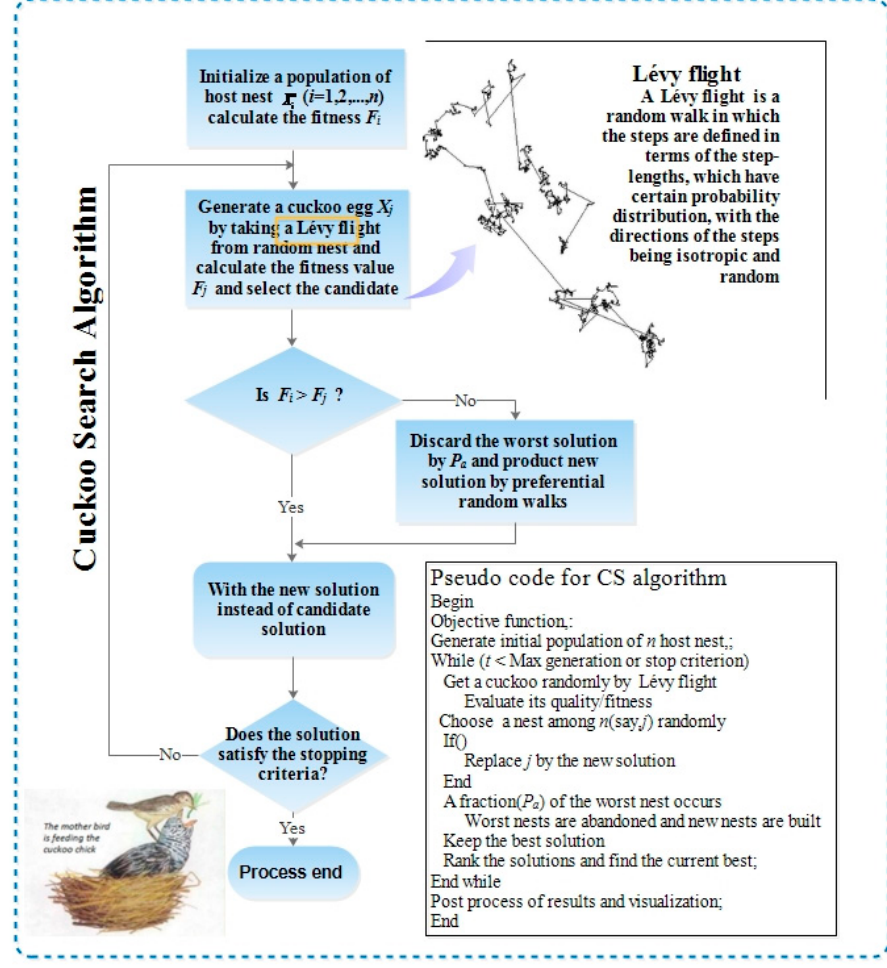
Figure 1. The flowchart of the Cuckoo Search Algorithm.